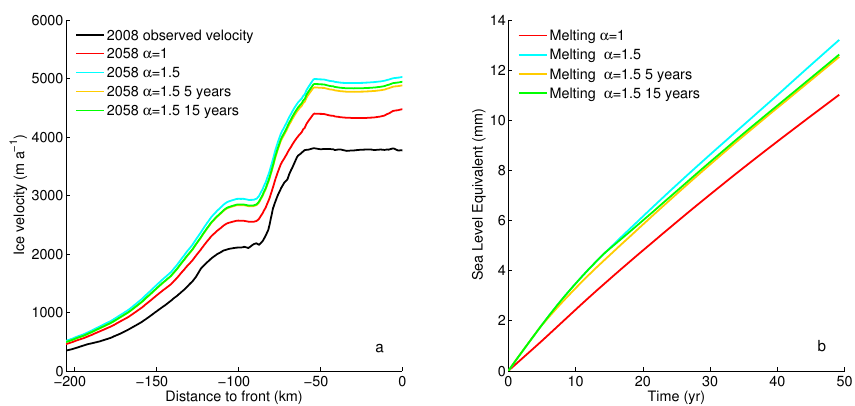
Figure 8. Modeled velocity sensitivity (a) and volume above floatation sensitivity (b) to increased ice shelf melting over a limited time. Ice shelf melting is multiplied by 1.5 during the first 0 (red), 5 (yellow), 15 (green) and 50 (blue)yr of the simulation.